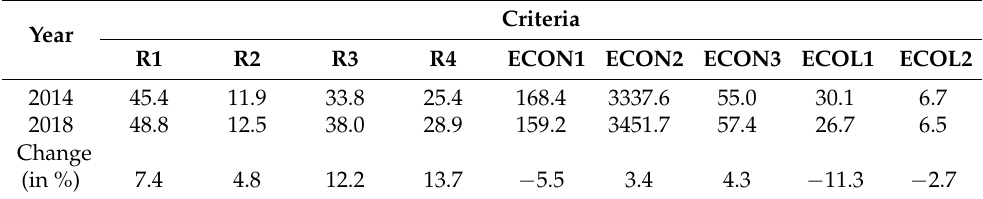
Table 8. Changes between derived groups in 2014 and